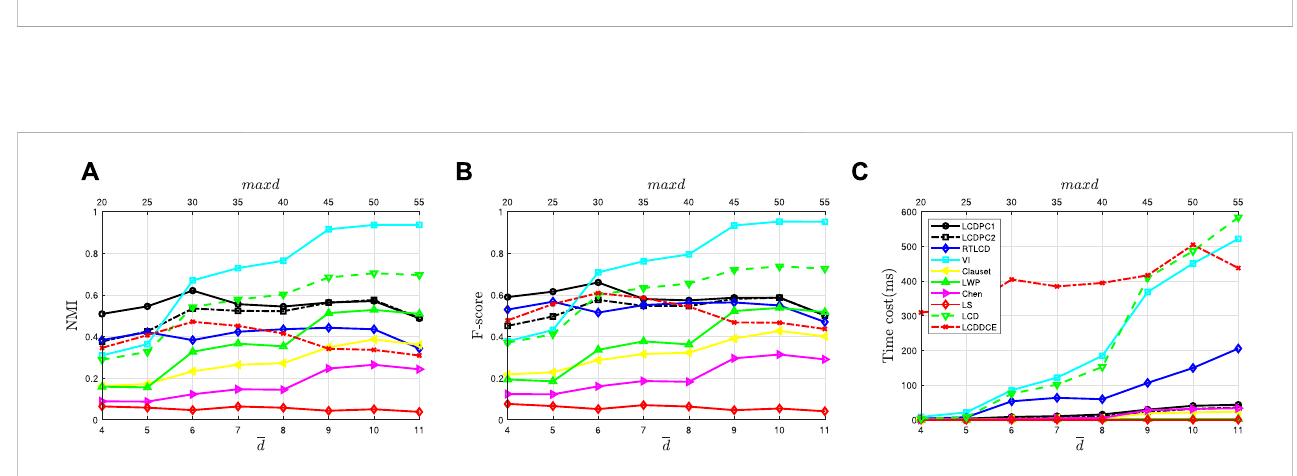
FIGURE 8 The performance of algorithms on LFR- α degree . (A) NMI on LFR- α degree . (B) F-measure on LFR- α degree . (C) Time cost on LFR- α degree